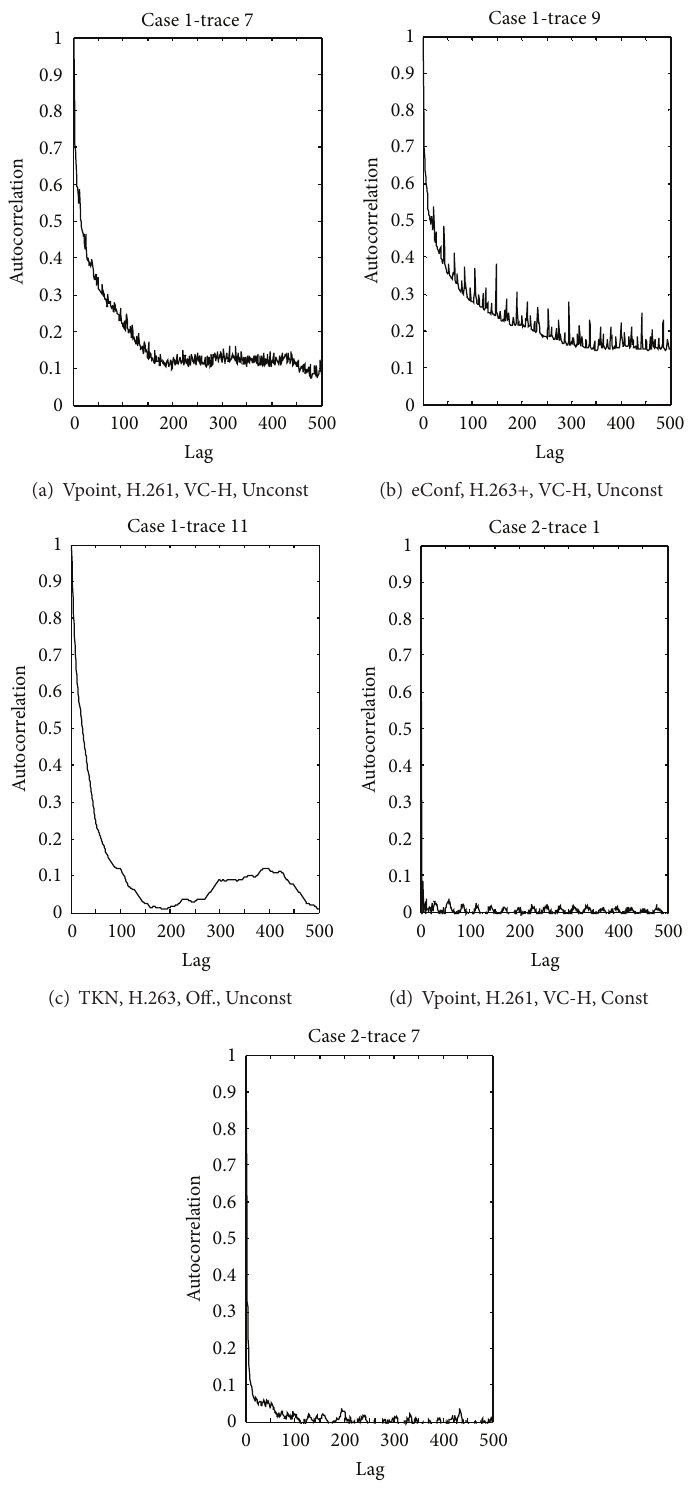
F 3: Autocorrelation graphs for unconstrained and constrained